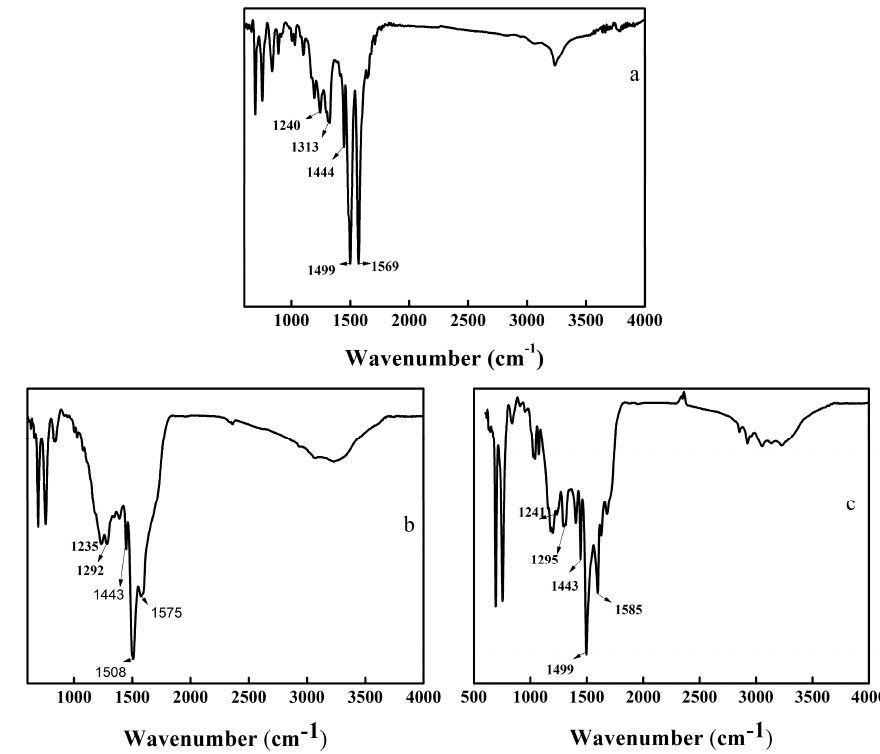
Figure 8. Fourier transform infrared spectra for the synthesized polyaniline. Under catalysis: ( a ) free hematin; ( b ) hematin ‐ MPTS ‐ M ‐ MWCNTs; ( c ) hematin ‐ MPTS ‐ M ‐ MWCNTs with addition of polyaspartic acid.